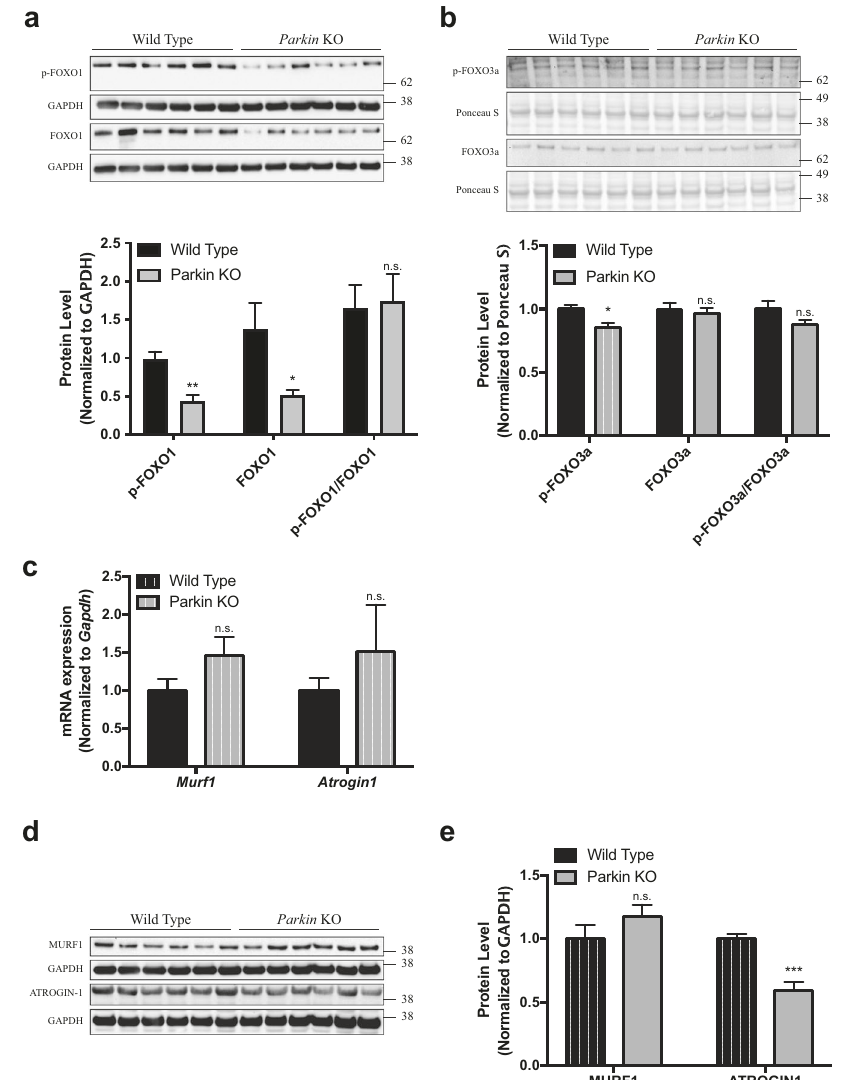
Fig. 2 Knock out of Parkin results in moderate but not signi fi cant increase in MURF1 protein levels in Gas muscle. a Top, Representative images of western blot analysis of phosphorylated FOXO1 (p-FOXO1) and total FOXO1 in wild type and Parkin KO Gas muscle. The levels of GAPDH were assessed as a loading control ( n = 6). Bottom, Graph showing quanti fi cation of p-FOXO1, total FOXO1 and p-FOXO1/total FOXO1 levels, normalized to GAPDH, in arbitrary units. ( n = 6). b Top , Representative images of western blot analysis of phosphorylated FOXO3a (p- FOXO3a) and total FOXO3a in wild type and Parkin KO gas muscle. The levels of ponceau S were assessed as a loading control ( n = 6). Bottom, Graph showing quanti fi cation of p-FOXO3a, total FOXO3a and p-FOXO3a/total FOXO3a levels, normalized to GAPDH, in arbitrary units. ( n = 6). c Graph showing qPCR analysis of atrogenes Murf1 and Atrogin1 in wild type and Parkin KO gas muscle. d Representative images of western blot analysis of MURF1 and ATROGIN1 protein levels in wild type and Parkin KO gas muscle. The levels of GAPDH were assessed as a loading control ( n = 6). e Graph showing quanti fi cation of MURF1 and ATROGIN1 protein levels, normalized to GAPDH, in arbitrary units ( n = 6). Data represent mean ± s.e.m. with error bars indicating s.e.m., n.s. not signi fi cant, *** P < 0.001 (two-tailed Student ’ s t FOXO pathway may be responsible for degradation of skeletal Next, to explore the skeletal muscle speci fi c E3 ligase muscle proteins in mice. responsible for degradation of cytoskeleton proteins upon fasting, MURF1 protein levels were assessed. Western blot analysis revealed that upon fasting, MURF1 protein levels increase more in Parkin KO mice as compared to wild type control (Fig. 5a). Moreover, microarray analysis revealed that genes expressing for proteasome proteins were upregulated in Parkin KO mice following 48 h fasting (Fig. 5b), suggesting increased catabolism in skeletal muscle of Parkin KO mice following starvation. Altogether, these data suggest that loss of Parkin in skeletal muscle results in an exacerbated muscle mass loss upon starvation. Microarray analyses indicate that increased expression of genes regulating proteasome activity, ubiquitin pathway and